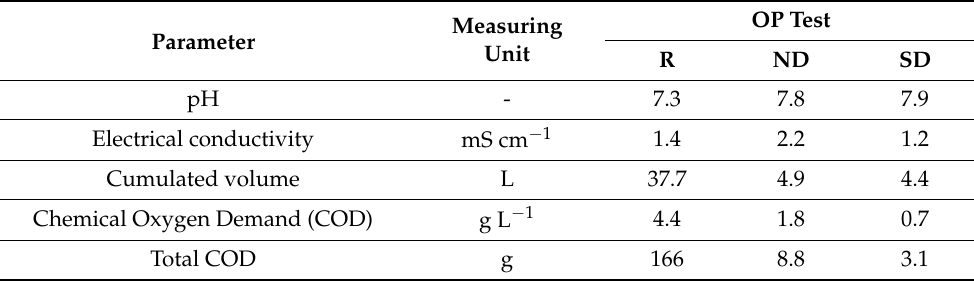
Table 3. Main average physico-chemical properties of the leachate produced by the orange peel (OP) in the lysimetric tests. Measuring Parameter